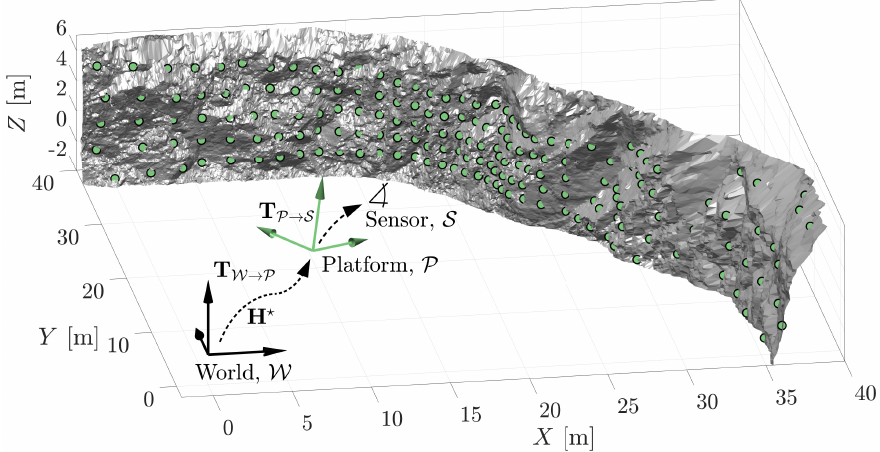
Figure 19. Example localisation problem. The MSOE algorithm is demonstrated to provide the pose of the platform frame, P , with respect to the World coordinate frame, W